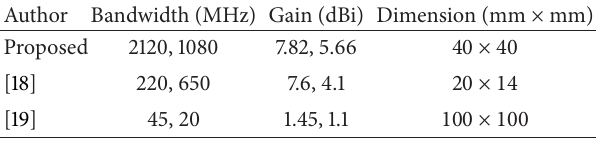
Table 2: Comparisons between existing and proposed